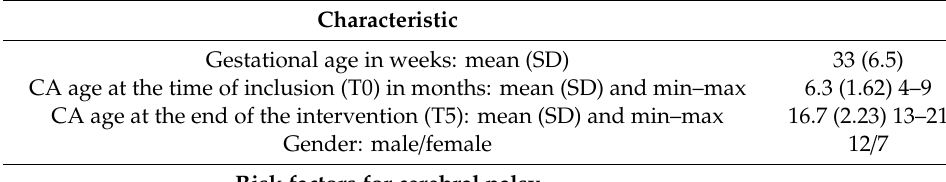
Table 1. Baseline demographic characteristics, diagnosis, and classifications of the participants involved in this study ( n =